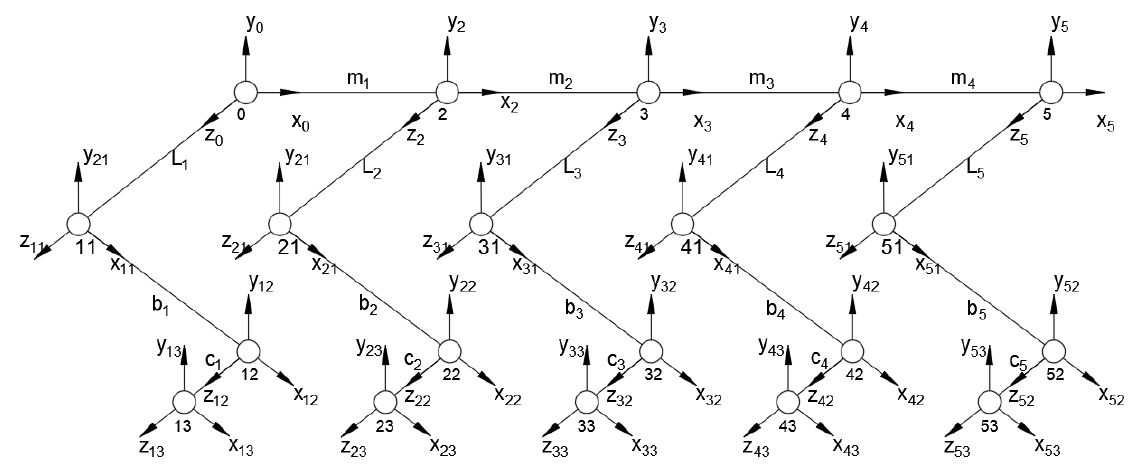
Figure 4. Unilateral coordinate system of torsion bar suspension chassis. According to the D-H coordinate transformation rule, a i − 1 represents the length of the connecting rod i − 1, which refers to the vertical distance between the axis of the i − 1 joint and the axis of the i joint; α i − 1 represents the torsion angle of the connecting rod i − 1, if there is an angle between the two straight lines in the space, even if they do not intersect, then the torsion angle α i − 1 is the angle between the joint i − 1 and the joint i axis. d i denotes the offset of the connecting rod i relative to the connecting rod i − 1. There is a typical vertical line between the joint i and the front and rear joint axes, and the distance between the two standard vertical lines is the offset of the connecting rod i close to the connecting rod i − 1; θ i is the joint angle, indicating the rotation angle of the connecting rod i relative to the connecting rod i − 1 around the i axis [28]. According to the above definition and the motion model of the fish-bellied swing arm torsion bar suspension, the D-H parameters corresponding to each adjacent coordinate system can be obtained, as shown in Table